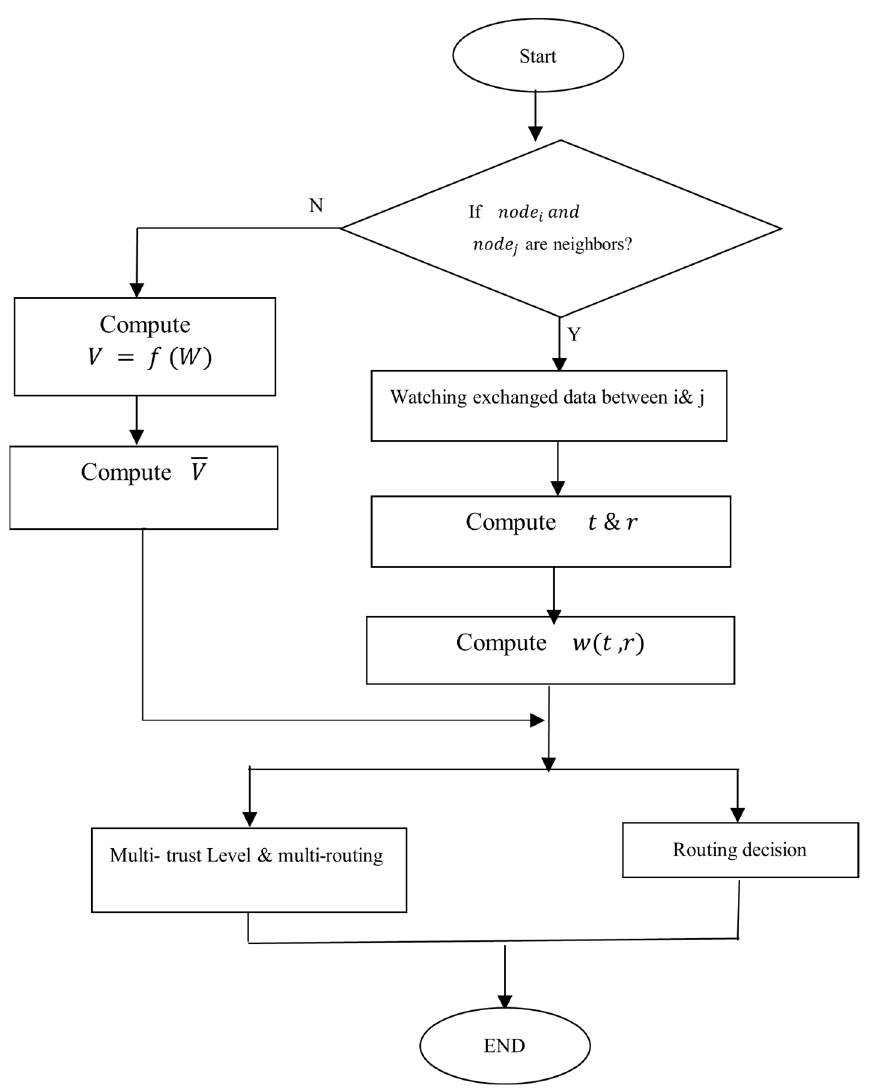
Figure 2. Flowchart of TAT Routing Protocol.